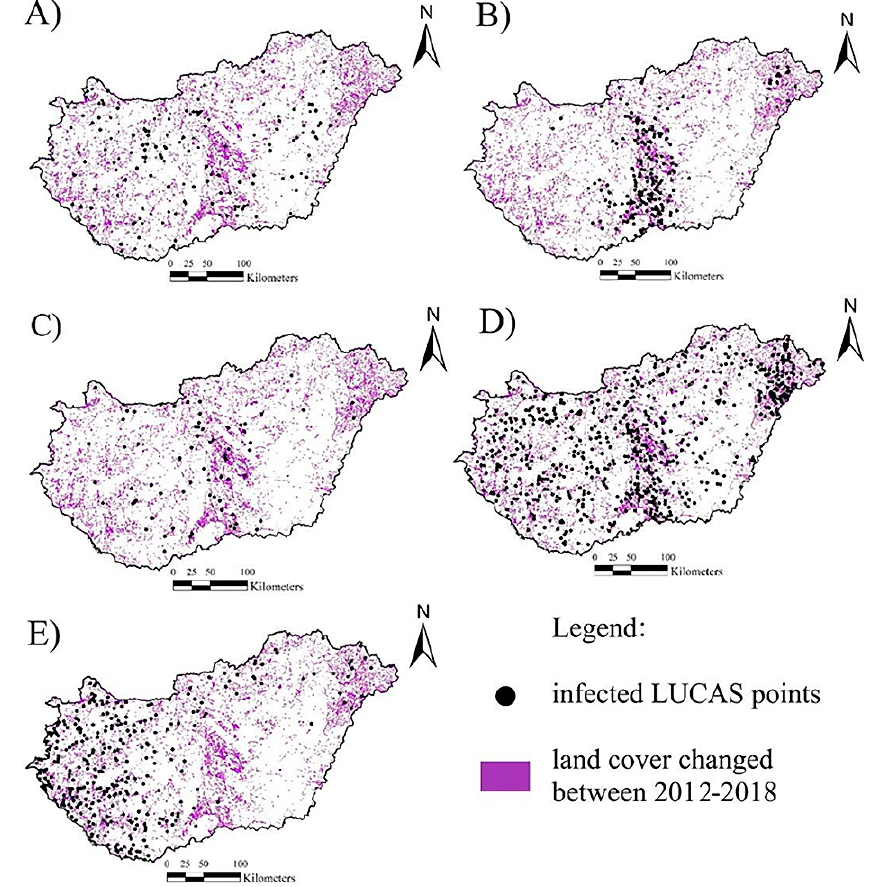
Figure 1. The areas with changed land cover, and the country-scale distribution of the investigated five invasive